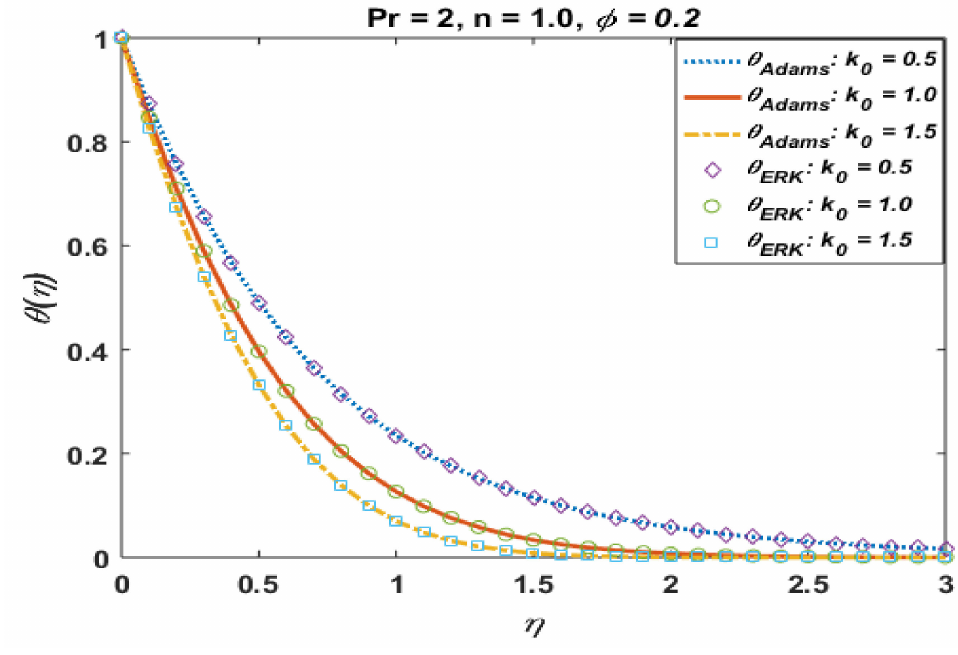
Figure 17. Effects of k 0 on θ